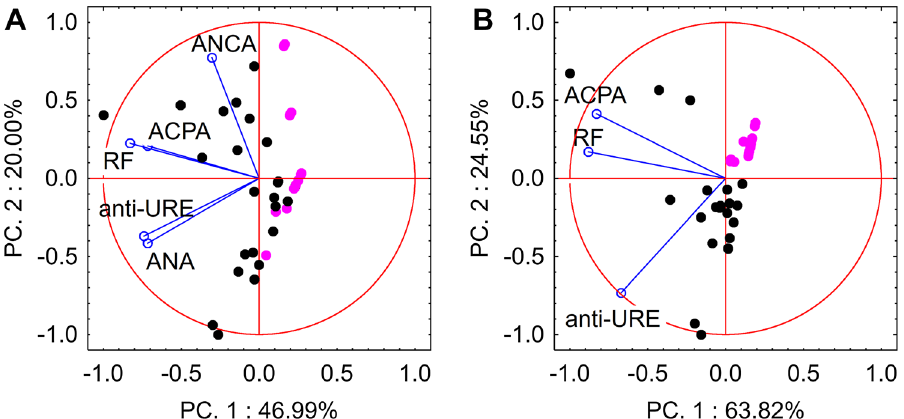
Figure 1. The PCA biplot displays the correlations: ( A ) between the five clinical markers and individual serum samples, PC1 and PC2 accounted for 66.99% of the total variance, ( B ) between the three clinical markers and individual serum samples, PC1 and PC2 accounted for 88.37% of the total variance. Rheumatoid arthritis patients’ sera samples are marked in black (n = 23) and healthy blood donors’ sera samples are marked in pink (n = 16).